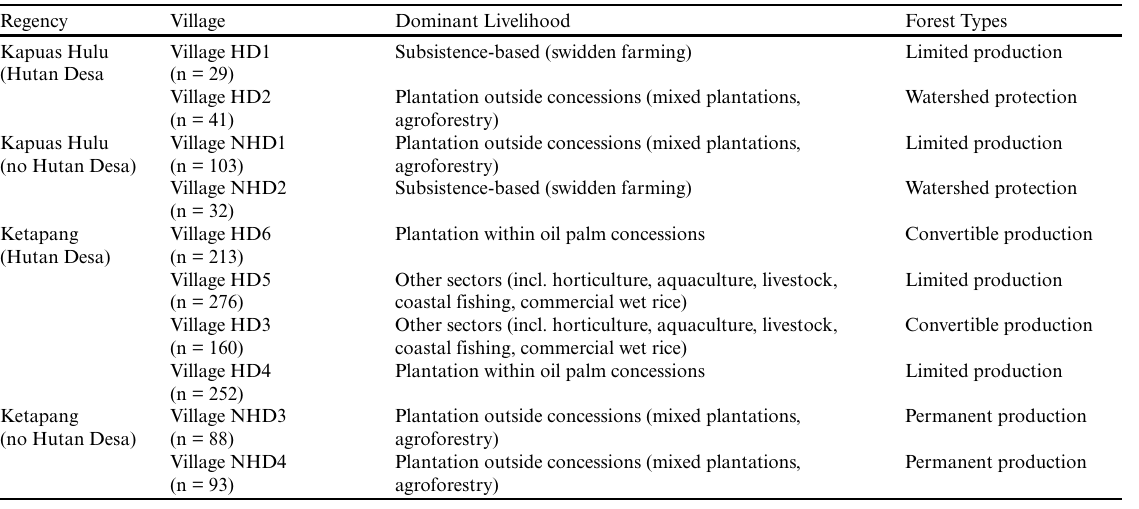
Table 1 . Study villages and attributes. Dominant livelihood was determined using Indonesia’s national census data (PODES) and is based on the primary livelihood sector and dominant concession type in a village (Santika et al. 2019). Forest type is based on the Ministry of Environment and Forestry classification of the forest estate and dictates what activities can occur.